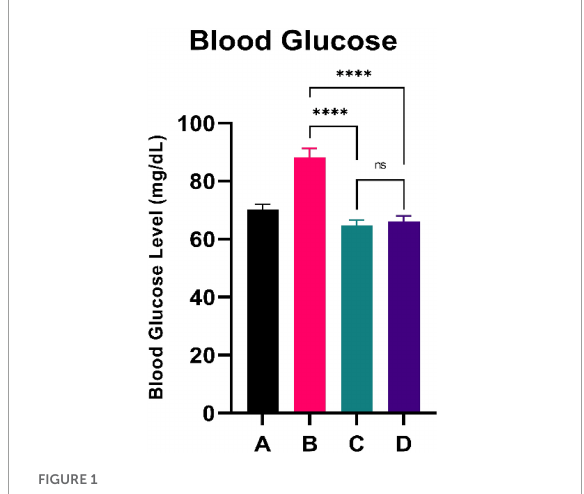
FIGURE1 Low doses are more effective in lowering blood glucose. ****Means a strong p -value of < 0.0001.